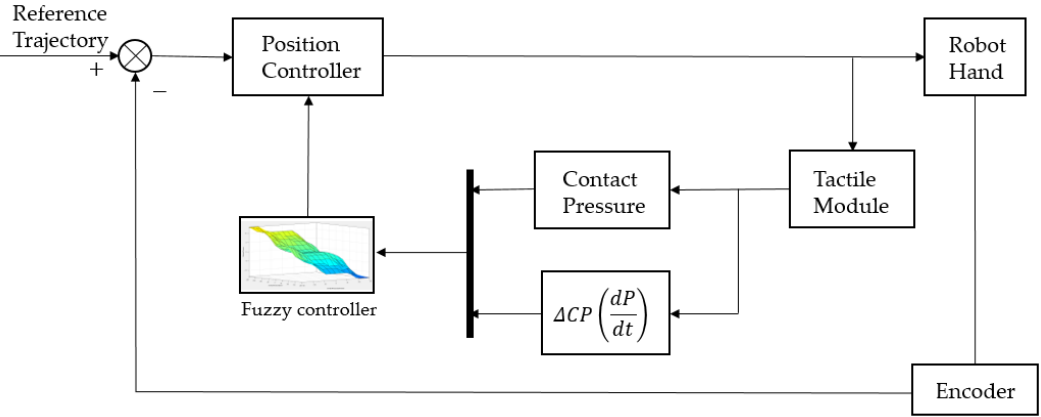
Figure 12. Optimal grasping controller.